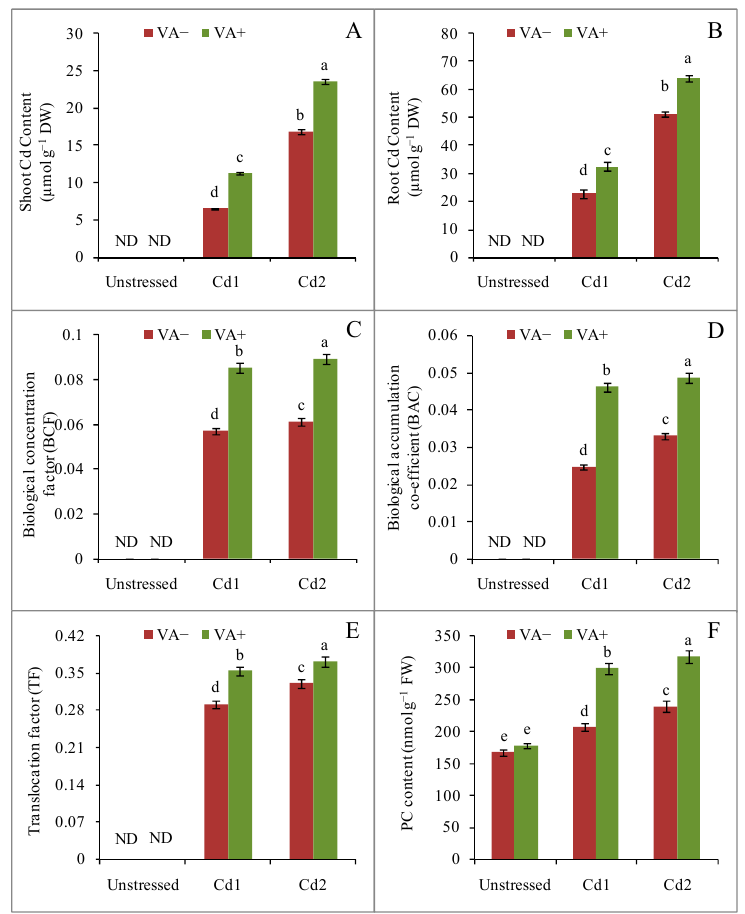
Figure 2. Effects of exogenous VA on Cd content of shoot ( A ), root ( B ), biological accumulation factor (BCF) ( C ), biological accumulation co-efficient (BAC) ( D ), translocation factor (TF) ( E ), and phytochelatin (PC) ( F ) contents of rice ( Oryza sativa L. cv. BRRI dhan54) seedlings under Cd toxicity stress. Mean ( ± SD) was computed from three replications of each treatment. Bars with dissimilar letters are significantly different at p ≤ 0.05 from Fisher’s least significant difference (LSD) test. The biological accumulation factor (BCF), biological accumulation co-e ffi cient (BAC), and Cd translocation factor (TF) also showed dose-dependent increases in response to Cd, and these values were further increased by VA supplementation (Figure